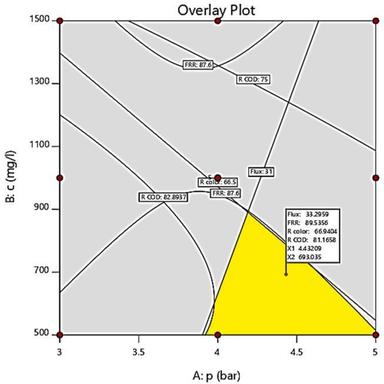
Overlay plot to process optimization.